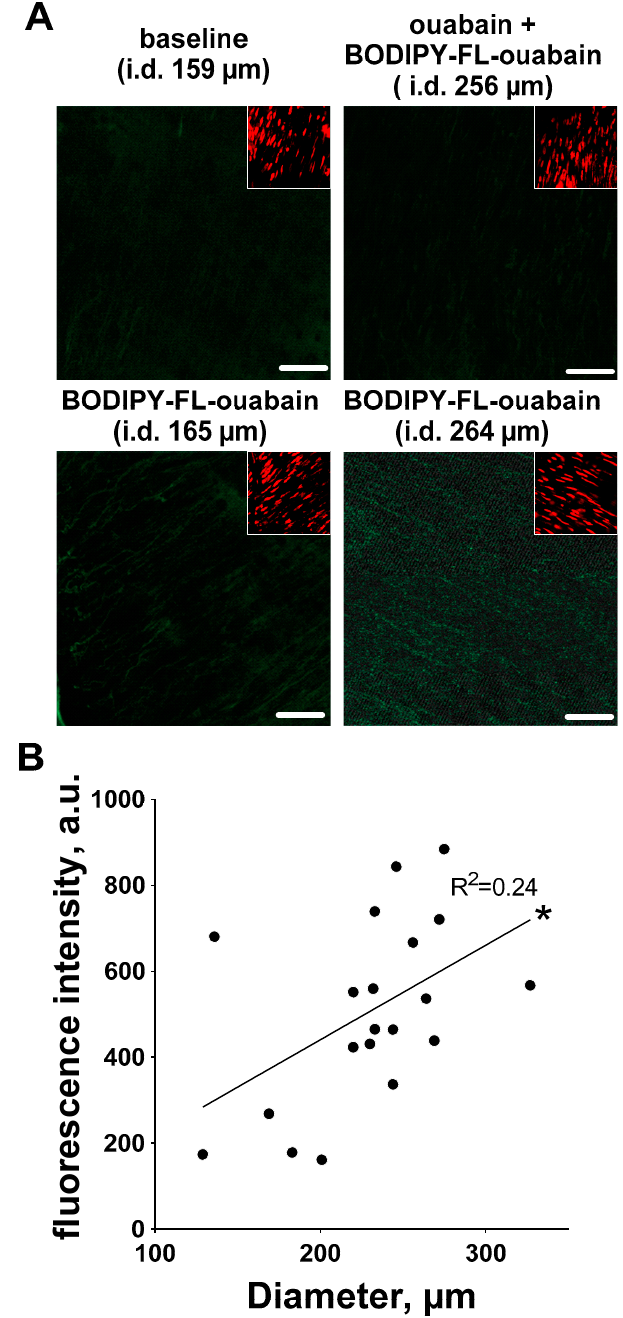
Figure 8. Increase in arterial diameter is associated with an increased density of the high-affinity ouabain binding sites. Arterial segments of different diameter were incubated with 10 µM BODIPY FL ouabain. ( A ) shows representative images of arterial segment without pharmacological intervention (i.e., baseline), two arterial segments of different diameters as indicated treated with 10 µM BODIPY FL ouabain, and artery first pre-treated with 1 mM ouabain and then exposed to 10 µM BODIPY FL ouabain (bars indicates 20 µm). Fluorescence intensity was measured in smooth muscle layer in the vascular wall, as indicated by SYTO-82 based nuclei staining (inserts in images). BODIPY FL ouabain related fluorescence intensity increases with an increase in arterial inner diameter ( B ). R 2 on the graph indicates linear regression quantifies goodness of fit. n = 20, p < 0.05 (*).